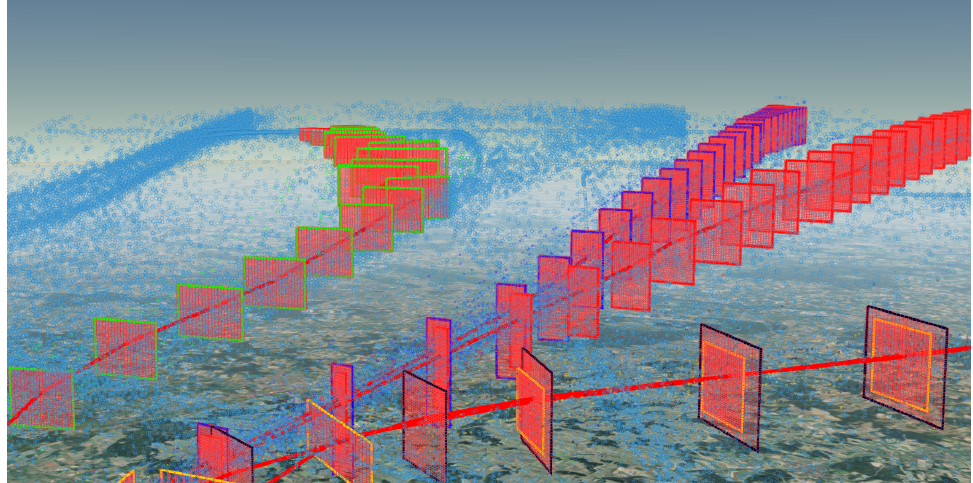
Figure 8. Four of seven 3D departure funnels with rectangular gates (red with unique border colors per funnel) from clustered flight data (09/2020), with the raw ADS-B data points (blue), and the mean trajectory per funnel (red lines). Blue points outside funnels are outliers or other